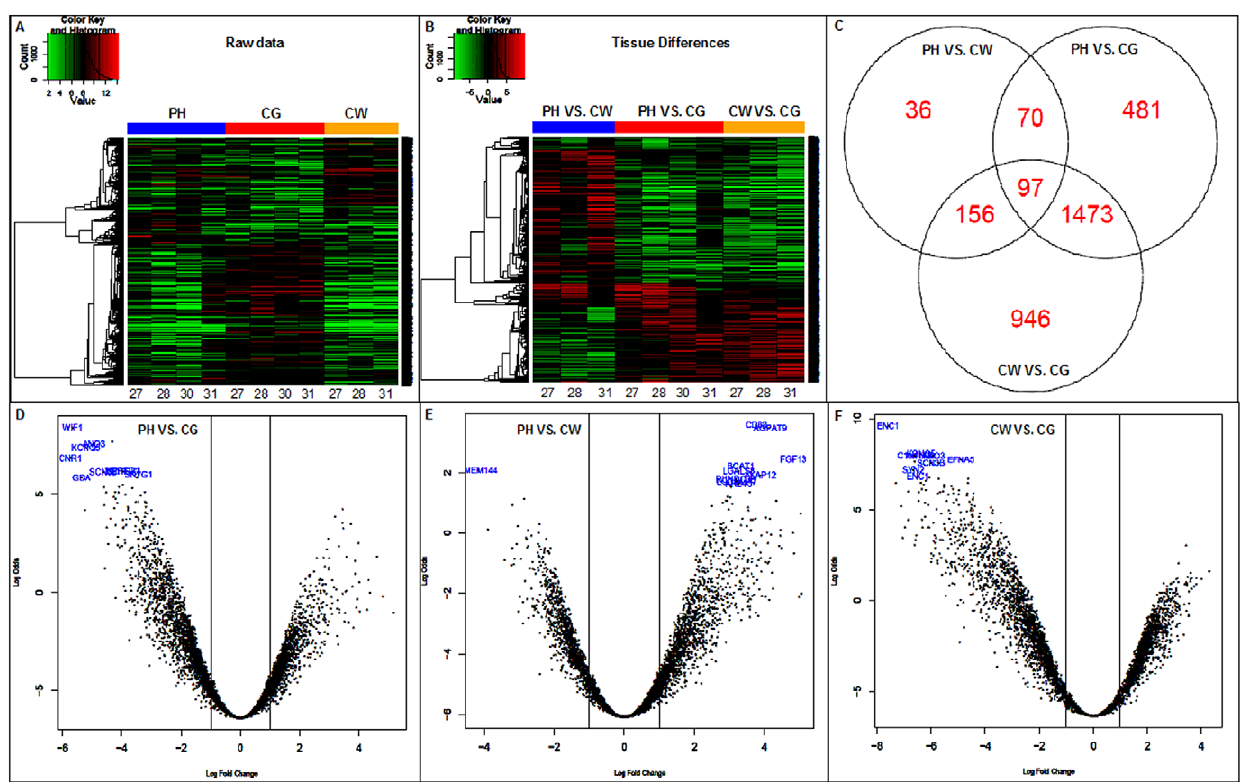
Figure 1. Raw data from the microarray analysis. A and B ) heat maps illustrating gene expression, C ) Venn diagram of a total of 3,259 genes significantly regulated; D , E and F ) volcano plots arranging the genes significantly expressed corresponding to the three comparison areas along dimensions of biological and statistical significance. PH (perihematoma), CW (contralateral white) and CG (contralateral grey).